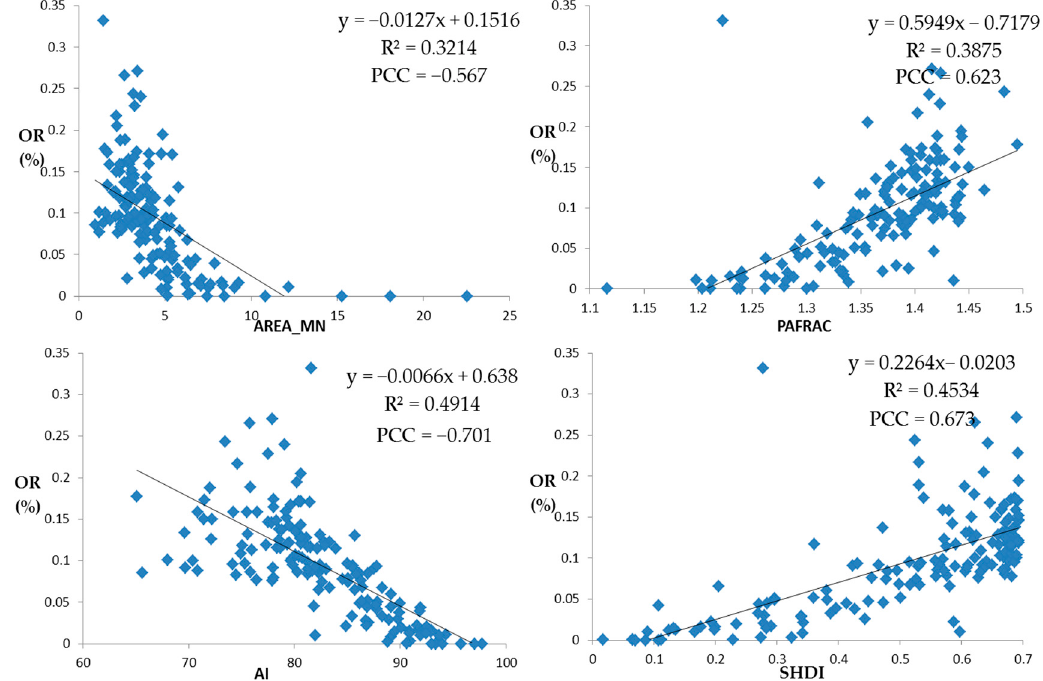
Figure 15. Regression modeling of optimization rate and landscape pattern index: ( a ) area-weighted mean of patch area (AREA_MN); ( b ) perimeter-area fractal dimension (PAFRAC); ( c ) aggregation index (AI); ( d ) Shannon’s diversity index (SHDI). Abbreviation: PCC, Pearson correlation coefficient.